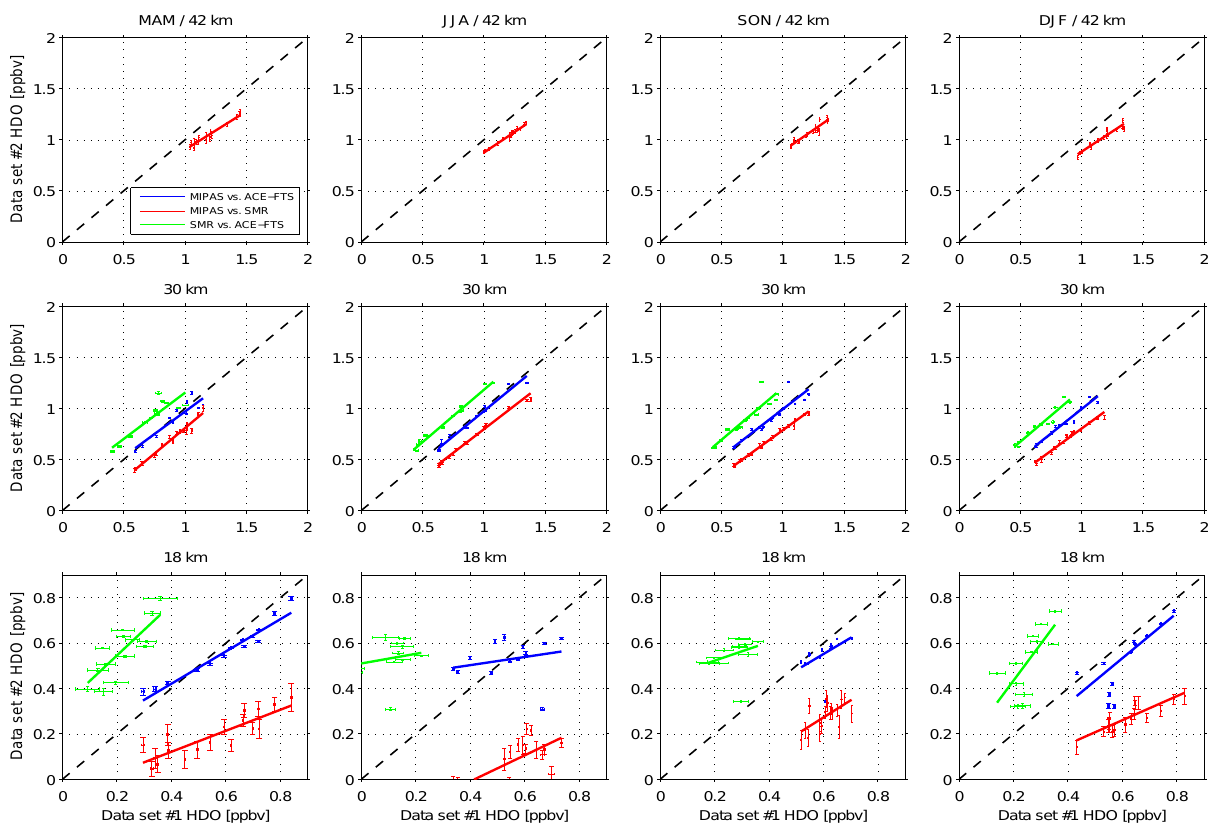
Fig. 5. Scatter plots based on the latitudinal cross sections at three representative altitudes for the different seasons. The comparison between MIPAS and ACE-FTS is shown in blue, MIPAS versus SMR is given in red while the comparison between SMR versus ACE-FTS uses green. The data set named first uses the abscissa, the latter one the ordinate. The solid lines represent the line fits for the individual comparisons. Note that different scales are used for the axes depending on altitude. The dashed line gives the ideal fit (intercept=0,